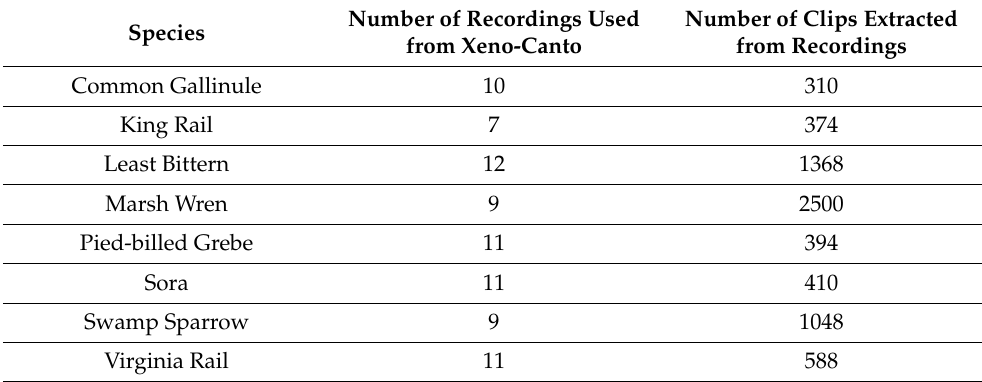
Table 1. Number of recordings selected from xeno-canto by species and number of species-specific clips extracted.